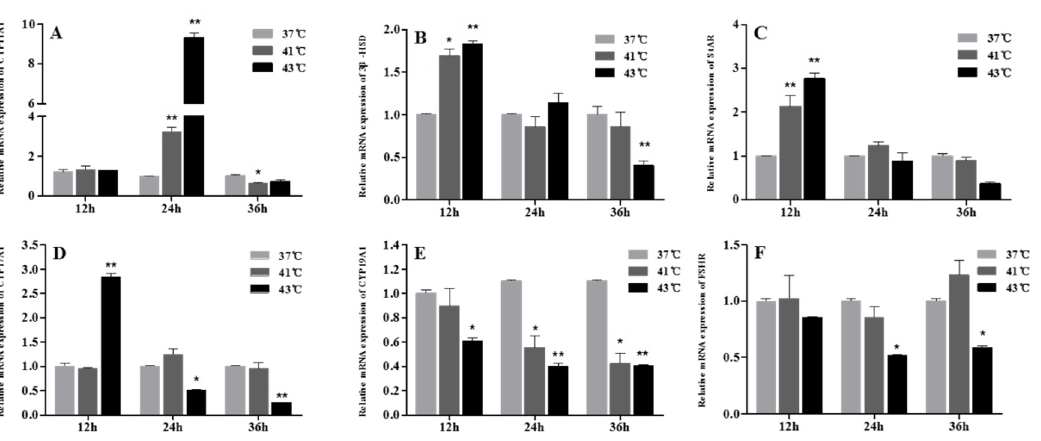
Figure 4. Effect of heat treatment on expression levels of progesterone and estradiol synthesizing enzymes in granulosa cells. ( A – F ) CYP11A1, StAR, 3 β -HSD, CYP11A1, CYP17A1, CYP19A1, FSHR, CYP19A1, and FSHR mRNA expression levels, respectively. * p < 0.05, ** p < 0.01.